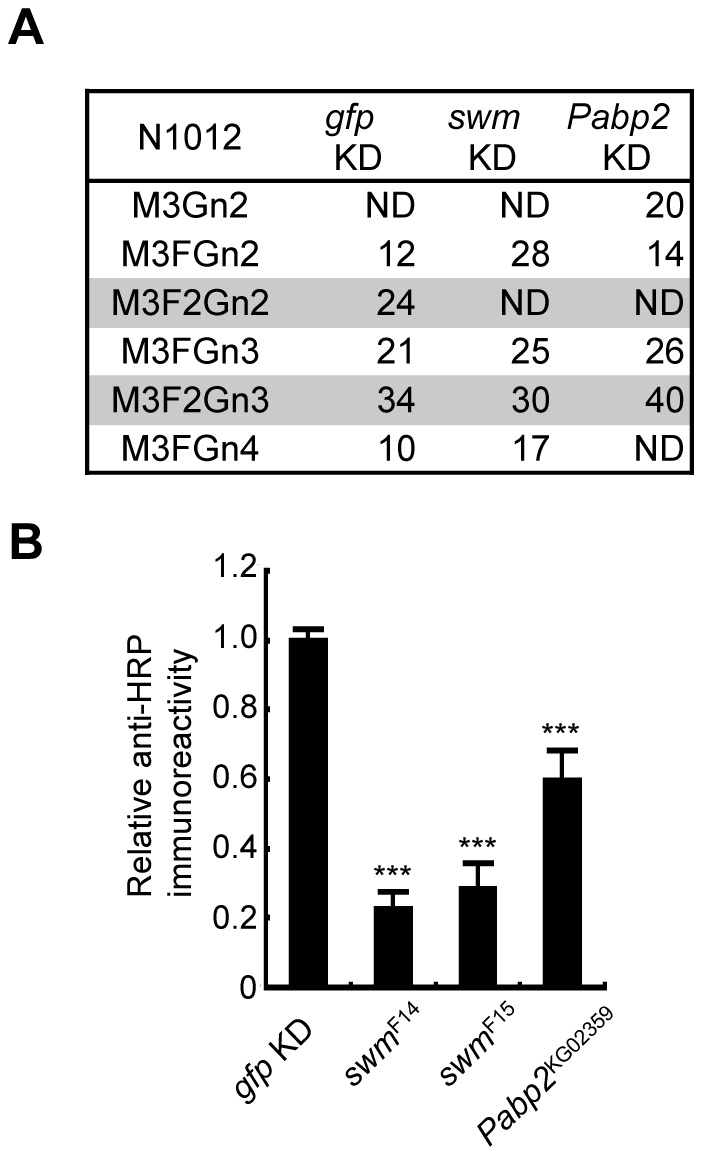
Swm and Pabp2 are required for neural-specific α1,3-fucosylation.(A) Glycan structures attached to N1012 of Chp as revealed by mass spectrometry analysis. The percentages of each structure in the control (left, gfp KD), swm (middle, swm KD), or Pabp2 (right, Pabp2 KD) knockdown condition are listed. The glycans bearing α1,3-fucose are highlighted (gray). ND, not detected. (B) α1,3-fucosylation in swm and Pabp2 mutants. Anti-HRP antibody reactivity normalized to Chp levels was markedly decreased in swmF14, swmF15, and Pabp2KG02359 mutants. Results are the mean ± SD of 3 experiments. ***p<0.005.